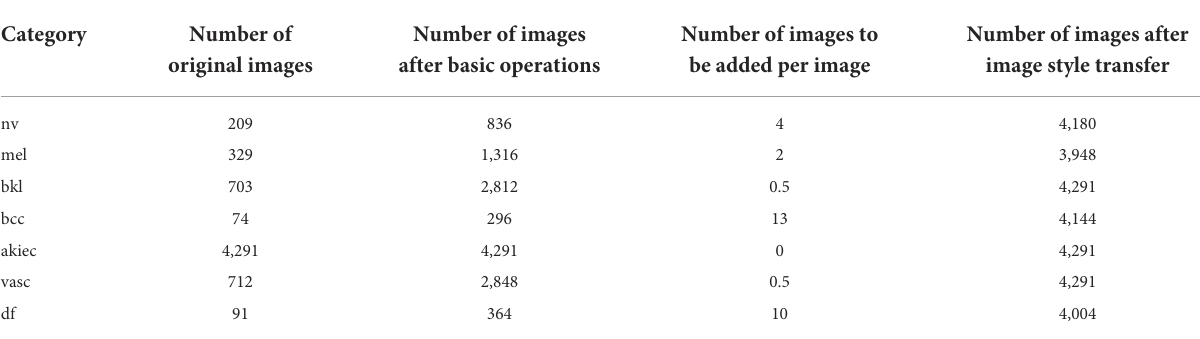
TABLE 1 Image number statistics during image